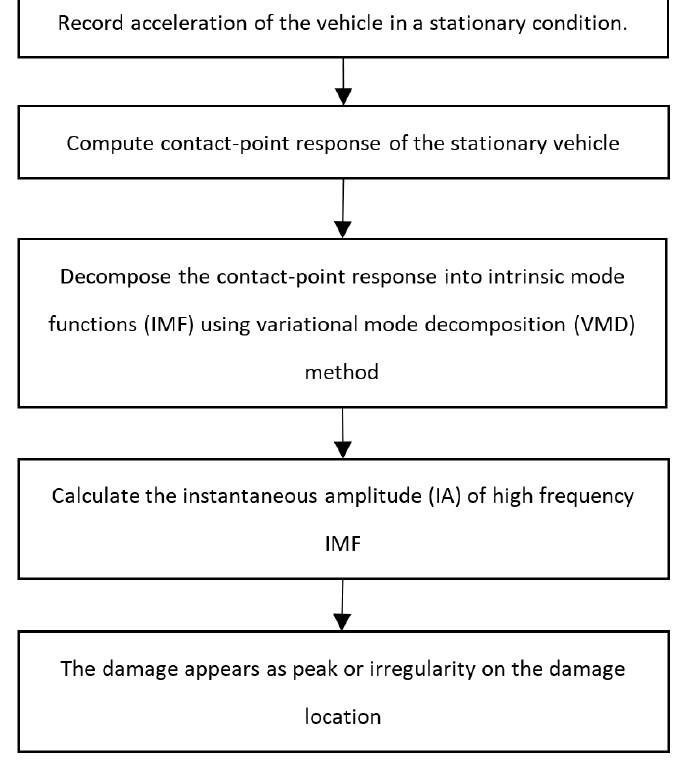
Figure 1. Schematic representation the proposed damage detection method.